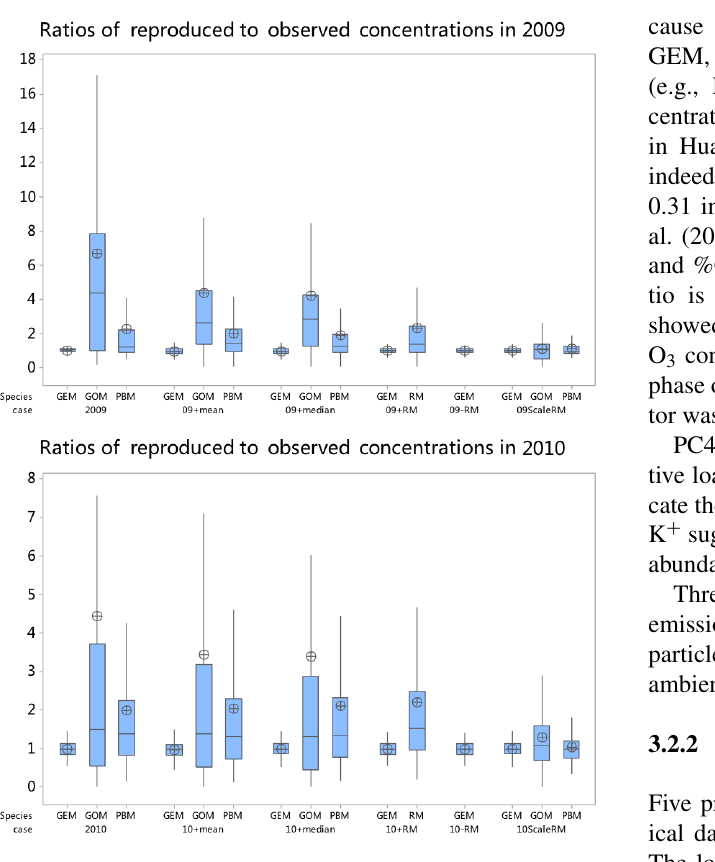
Figure 4. Box plot of reproduced to observed concentration ratios (upper whisker – upper 25% of the distribution excluding outliers; interquartile range box – middle 50% of the data; horizontal line in the box – median; lower whisker – lower 25% of the distribution excluding outliers; ⊕ –